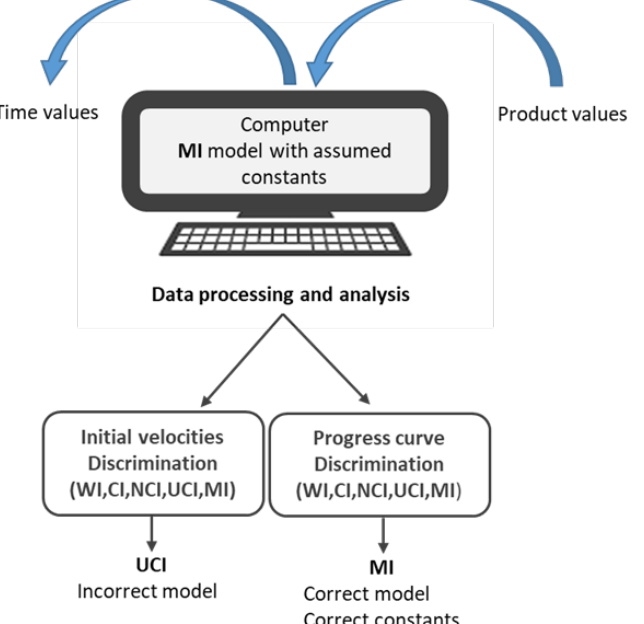
Figure 3. Scheme of theoretical framework developed in order to show that with the same data range, different kinetic models were obtained as a function of the chosen methodology (initial velocities or progress curve analysis).